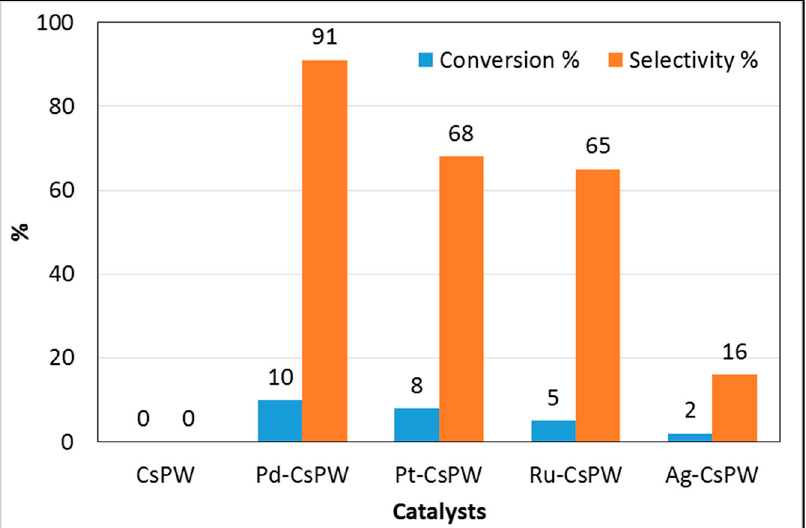
Figure 4. Liquid phase hydrogenation of MIBK over M-CsPW (M = Pd, Pt, Ru, Ag). Reaction conditions: 443 K, 25 mL of MIBK (solvent free), 0.25 g catalyst, 2 wt% of metal, 10 bar H 2 pressure, stirring rate of 780 rpm.